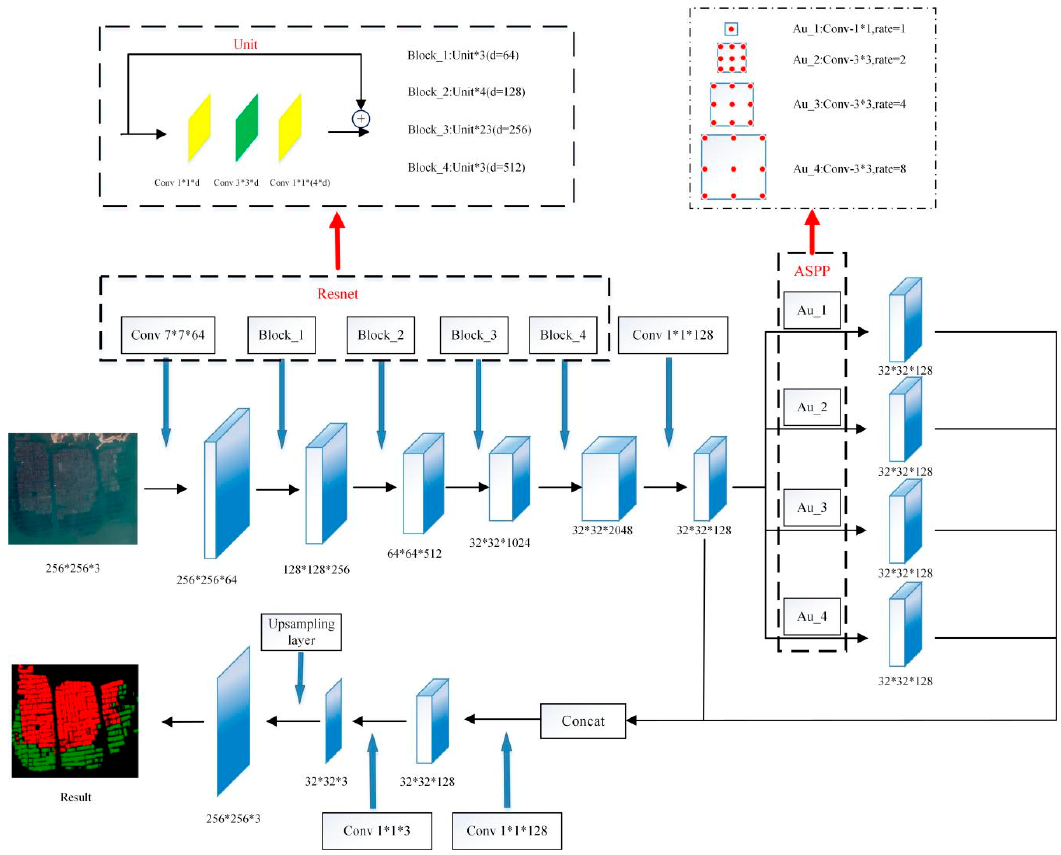
Figure 7. OAE-V3 network structure framework.